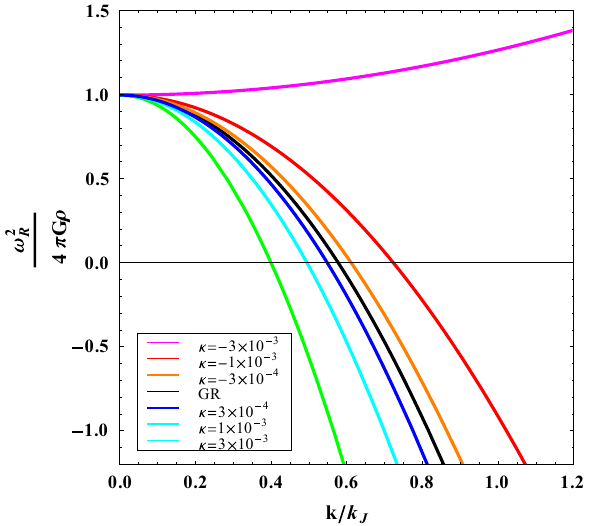
Fig. 2 ThegrowthrateoftheJeansinstabilityversus k / k J fordifferent values of the EiBI parameter. Here the dispersion relation is illustrated for the cases corresponding to κ < 0 ≈ 10 7 kg m − 3 . As expected, ρ threshold is ρ ∗ 0 formation region. Therefore, EiBI gravity can be